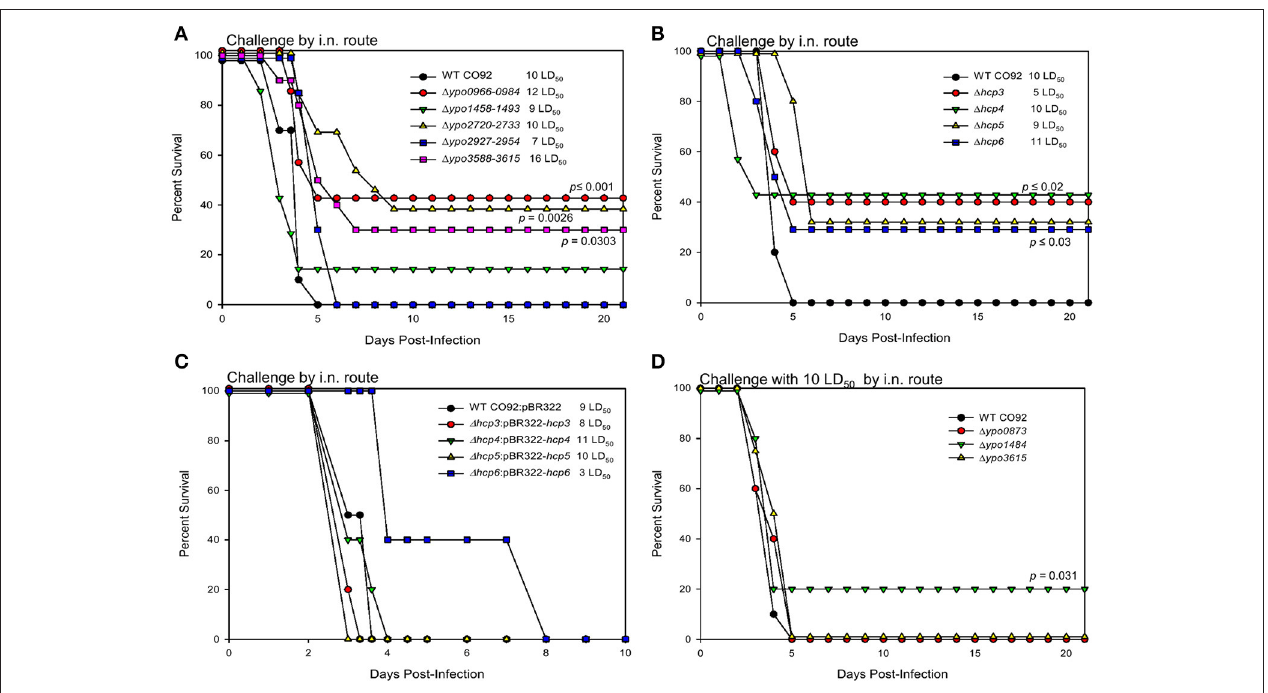
FIGURE 3 | Virulence of T6SS-associated genes in a pneumonic plague mouse model. Female Swiss-Webster mice were infected with WT CO92 or 1 of the 5 T6SS cluster deletion mutant strains: 1 ypo0966-0984, 1 ypo1458-1484, 1 ypo2720-2733, 1 ypo2927-2954, 1 ypo3588-3615 ( n = 7–12) (A) , or 1 of the 4 Hcp-encoding gene deletion mutant strains: 1 hcp3 , 1 hcp4 , 1 hcp5 , 1 hcp6 ( n = 7–12) (B) , or 1 of the 4 Hcp-encoding gene complemented deletion mutants strains: 1 hcp3 :pBR322- hcp3 , 1 hcp4 :pBR322- hcp4 , 1 hcp5 :pBR322- hcp5 , 1 hcp6 :pBR322- hcp6 ( n = 5) (C) , or 1 of the PAAR motif-containing protein-encoding gene deletion mutants: 1 ypo0873, 1 ypo1484 , 1 ypo3615 ( n = 10) (D) with the indicated LD 50 doses by the i.n. route. Animals were observed for morbidity/mortality for 10-21 days. The data were analyzed for significance by using Kaplan–Meier survival estimates. The P -values were determined based on comparison of animal